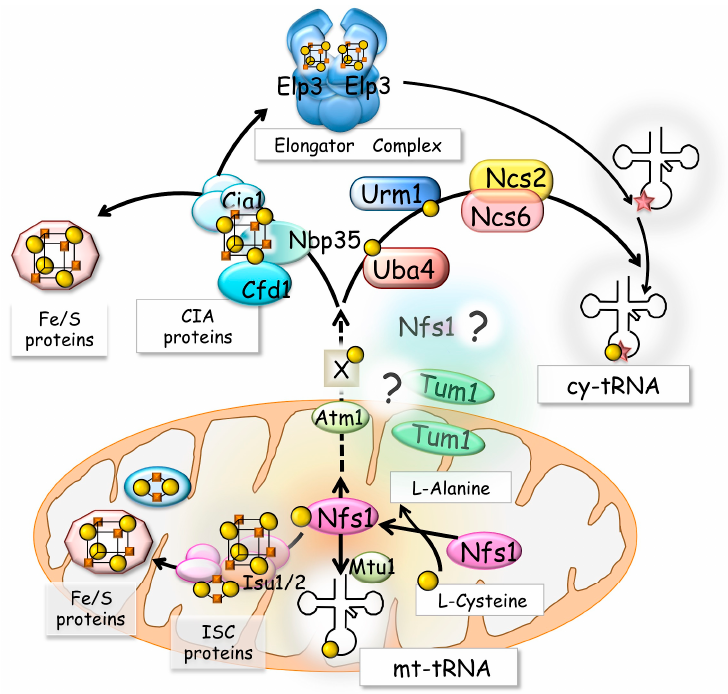
Figure 2. Involvement of the L ‐ cysteine desulfurase Nfs1 in transfer RNA (tRNA) modification and iron ‐ sulfur (Fe/S) cluster biosynthesis in Saccharomyces cerevisiae . The L ‐ cysteine desulfurase Nfs1, identified as a member of the iron ‐ sulfur cluster biogenesis (so ‐ called “ISC”) proteins, is essential for the biogenesis of s 2 U 34 in both cytosolic transfer RNAs (cy ‐ tRNAs) and mitochondrial transfer RNAs (mt ‐ tRNAs). Mtu1 is a mitochondrial tRNA ‐ specific 2 ‐ thiouridylase. Comparing to the case of